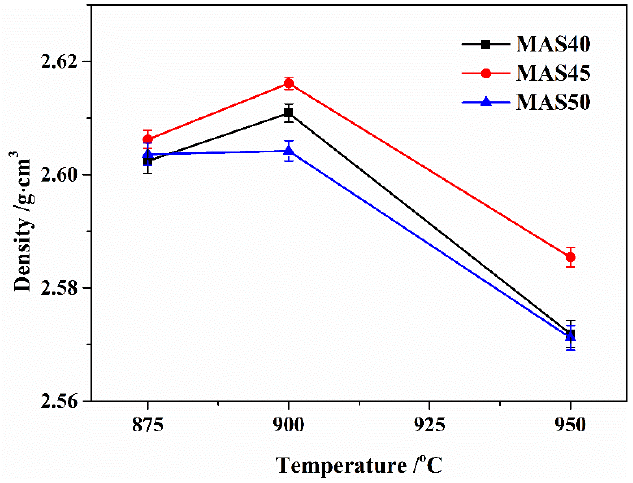
Figure 4. Density of the glass-ceramics sintered at different temperatures. The density variation of glass-ceramics sintered in the range 875–950 ◦ C is shown in Figure 4. According to Figure 4, all three basic glasses had excellent sintering properties, and the densities were in the range from 2.57 to 2.62 g · cm − 3 . The density of glass-ceramics was mainly determined by the chemical composition of the residual glass phase, porosity, and the type and content of crystals. The elements of Mg, Al, Si, and O in the basic glass formed the α -cordierite, and other elements in Table 1 existed in the residual glass